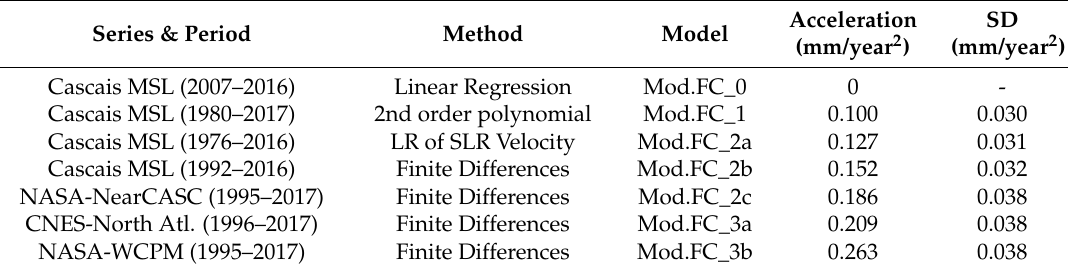
Table 3. List of SLR accelerations and respective standard deviation (SD) obtained with different methods, using the relative Cascais TG MSL and the satellite altimetry MSL anomalies of near the WCPM. Series & Period Method Model